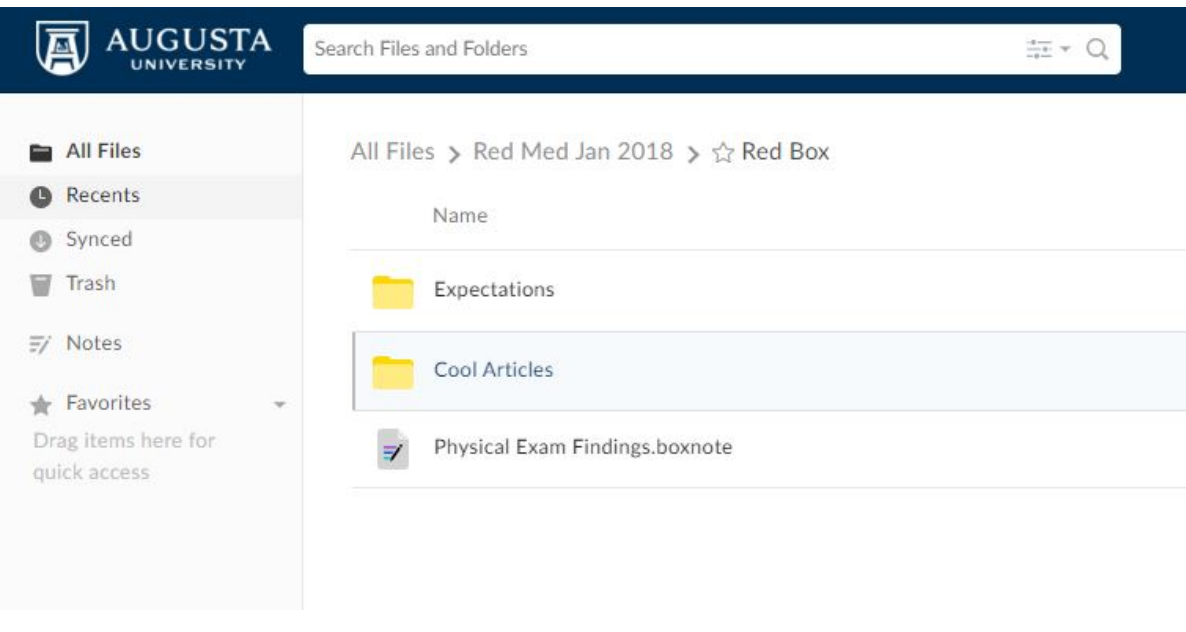
Figure 2. Screenshot of a Box folder from the first day of rotation. This screenshot displays the content of the "Red Box" section and is accessible to all